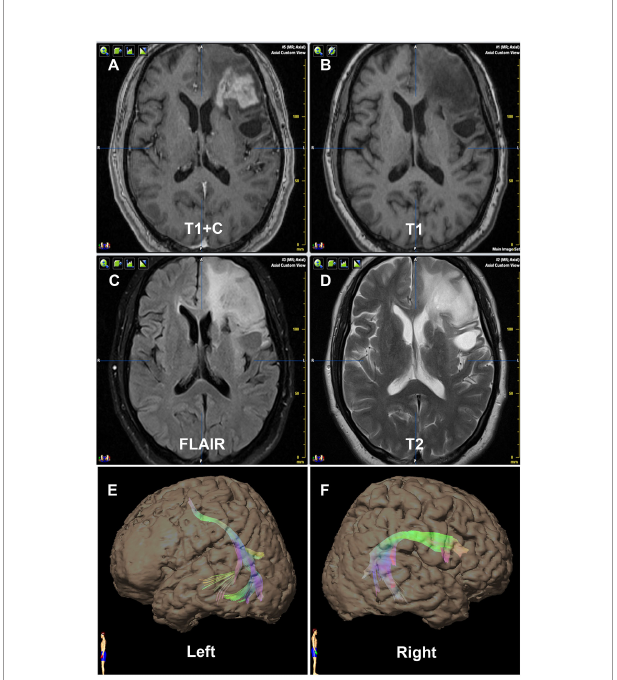
transverse slice of Patient No. 1, who was diagnosed as recurrent astrocytoma in site in Broca ’ s area. Panels (E, F) show that the relative more fi ber number and volume of AF are on the right hemisphere, which are in concordance with the language dominant side of the Wada test.